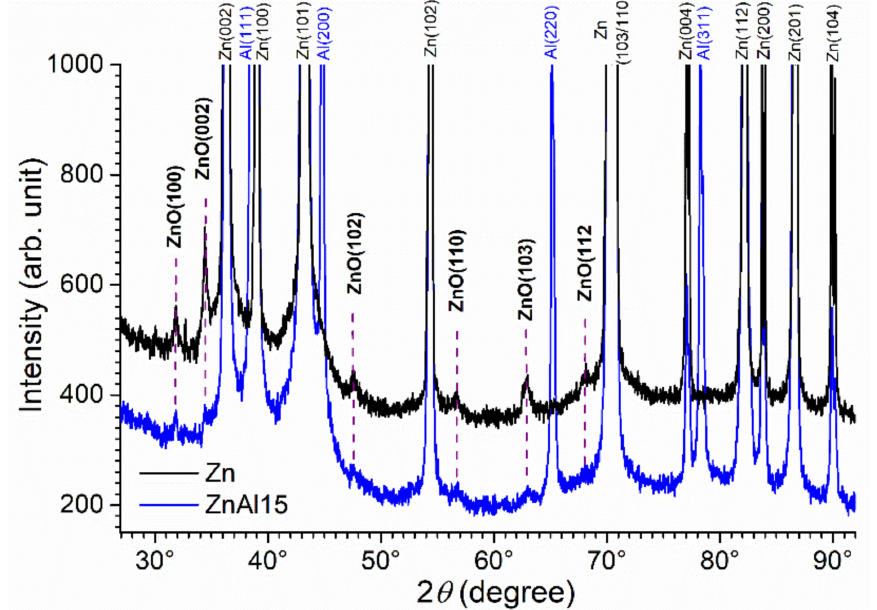
Figure 3. X-ray diffraction patterns of the Zn and Zn-15wt.% Al coatings before the corrosion experiments. Al(hkl) = aluminum, Zn(hkl) = zinc, and ZnO(hkl) = zincite, with the corresponding Miller index.